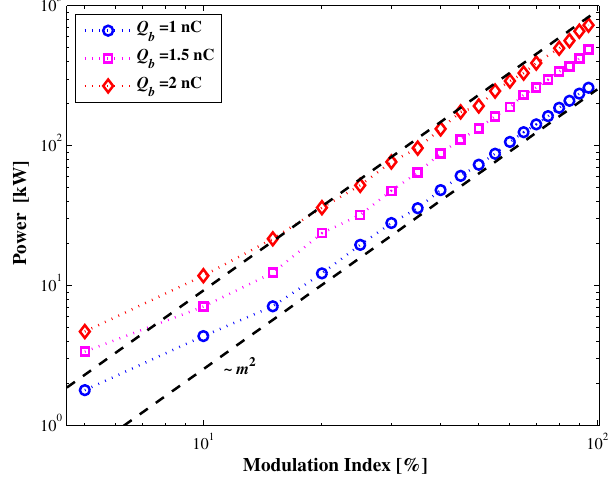
FIG. 8. Prebunched FEL radiation power as function of the modulation index m . The modulation frequency is f 3 THz. m ¼